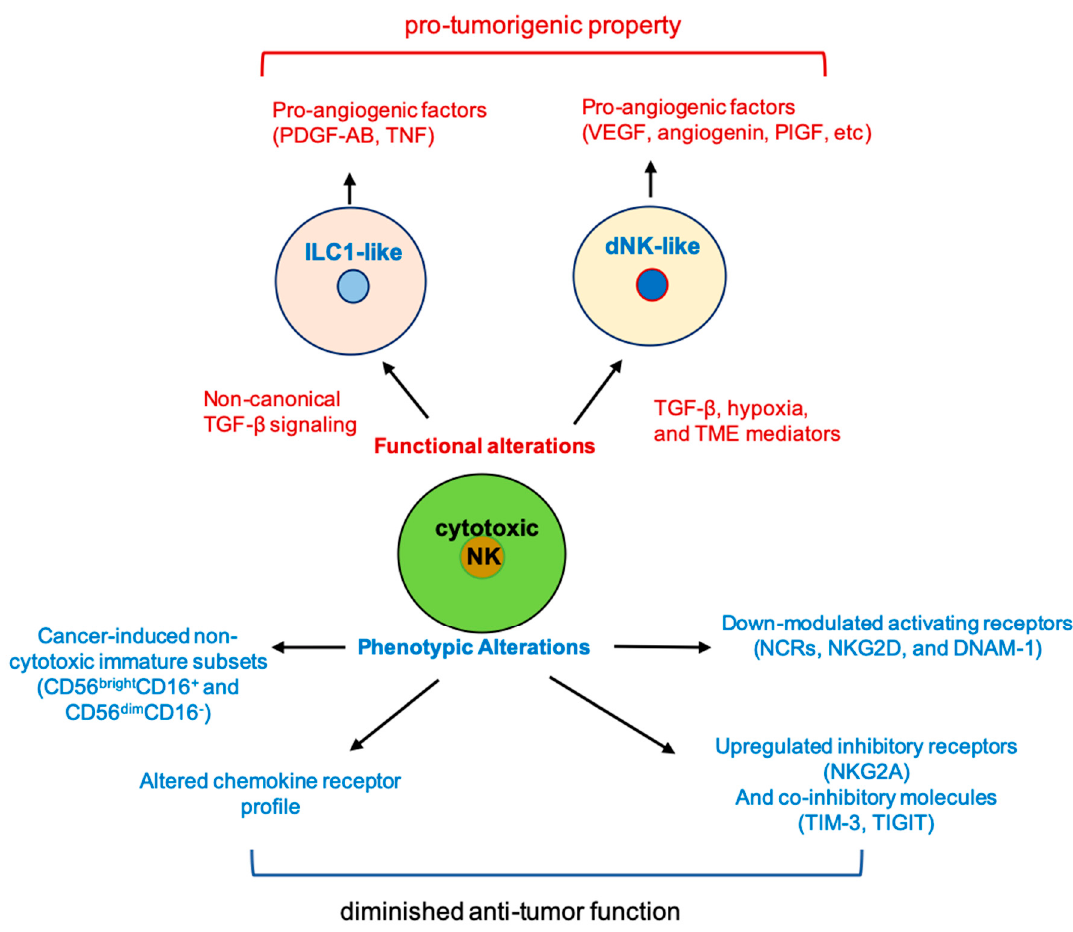
Figure 1. Cancer-induced phenotypic and functional alterations in natural killer (NK) cells. The function and phenotype of cytotoxic NK cells can be altered by tumor environment cues to become pro-tumorigenic or to lose anti-tumor function. PIGF, placental growth factor; ILC1, type I innate lymphoid cells; TME, tumor microenvironment; dNK, decidual NK; NCR, natural cytotoxicity receptor; DNAM, DNAX accessory molecule.